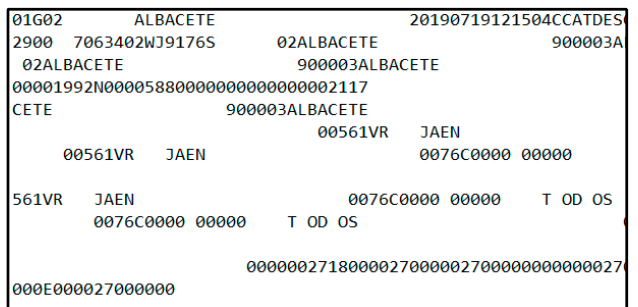
Figure 3. Flat-text formatless CAT file. Source: own preparation.